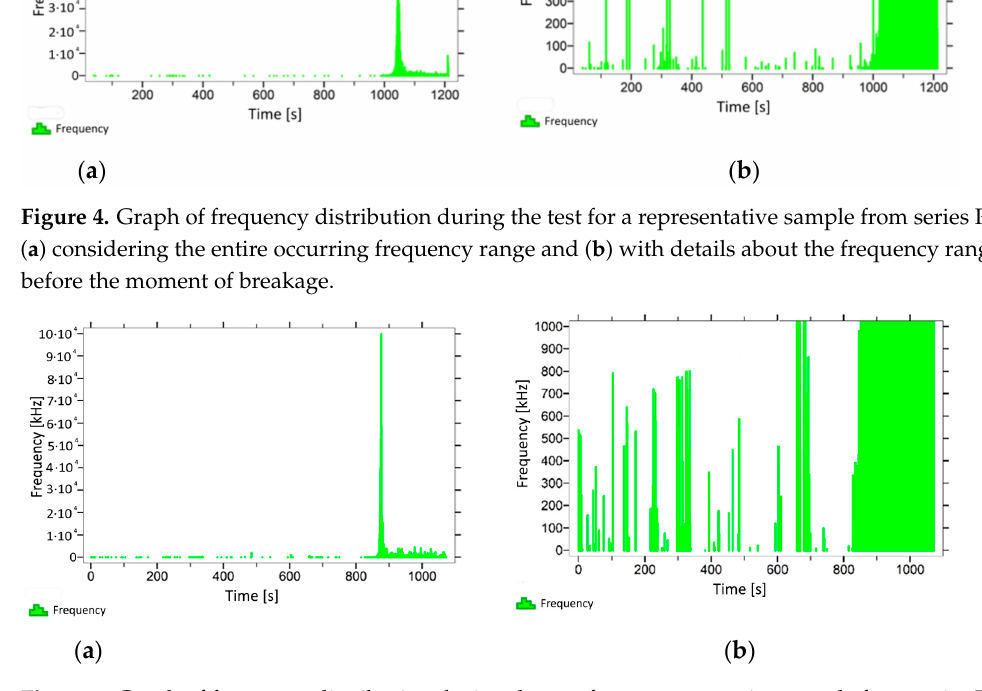
Figure 6. Graph of frequency distribution during the test for a representative sample from series P 5 : ( a ) considering the entire occurring frequency range and ( b ) with details about the frequency range before the moment of breakage.